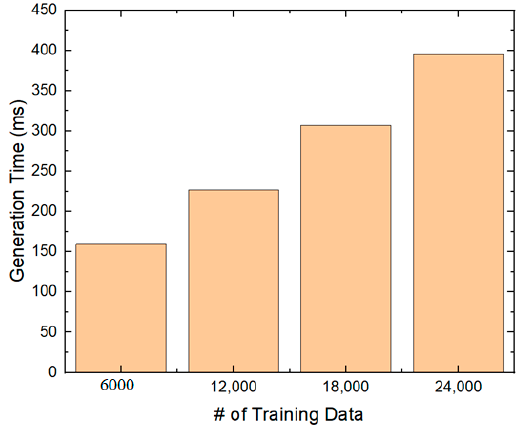
Figure 12. VP-tree generation time.